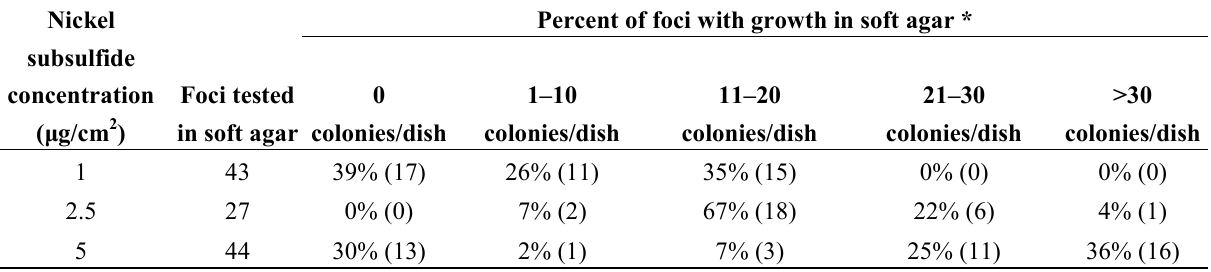
Table 3. Anchorage-independent growth of nickel subsulfide-induced